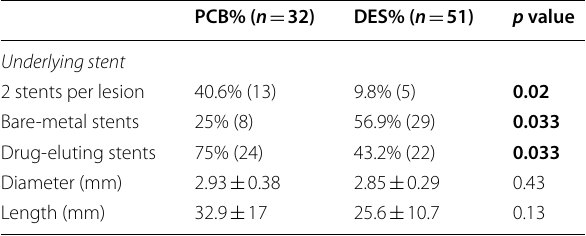
Bold values indicate p value significant (<